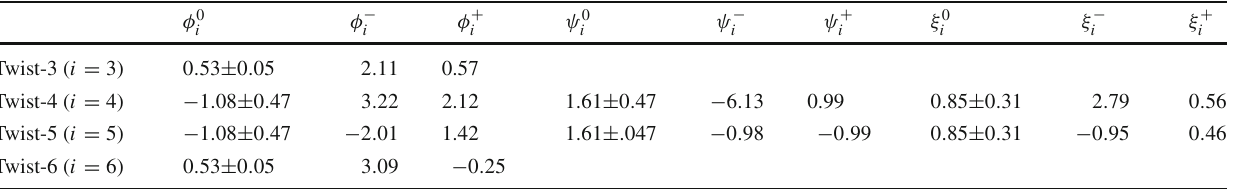
Table 2 Parameters in the proton LCDAs in units of 10 − 2 GeV 2 [74]. The accuracy of those parameters without uncertainties is of order of 50%